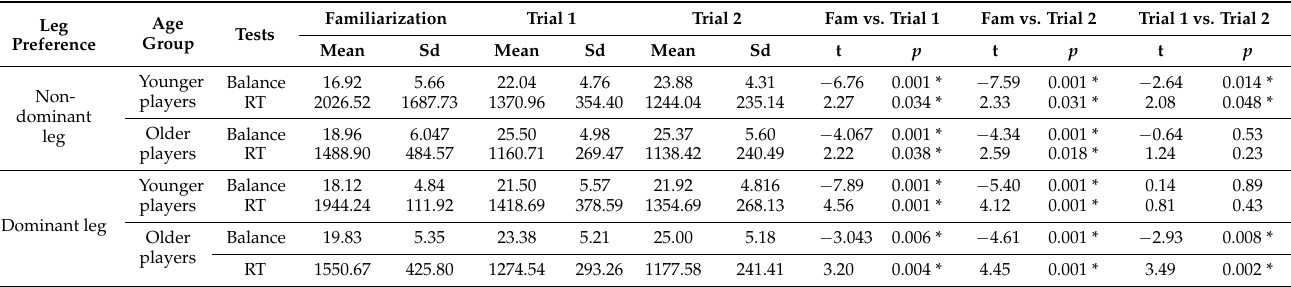
Table 3. Mean and standard deviation of the OLBA